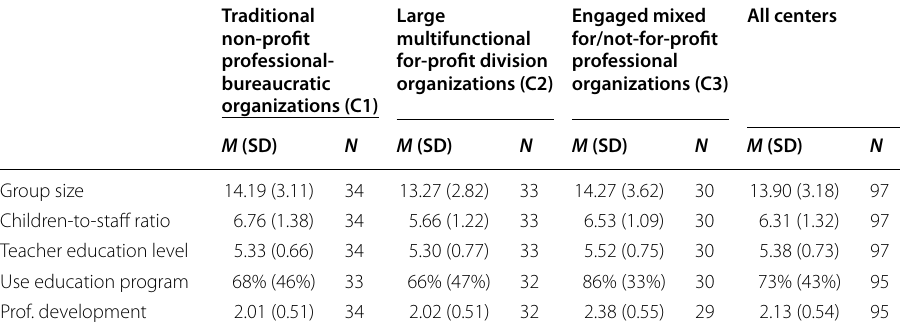
Table 3 Teacher-reported structural characteristics by organizational